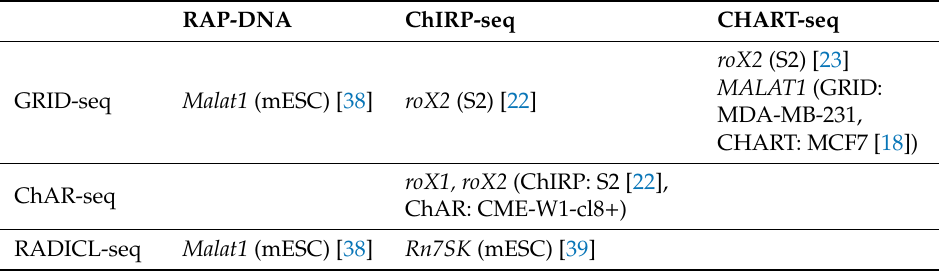
Table 2. RNAs analyzed by both all-to-all methods and one-to-all